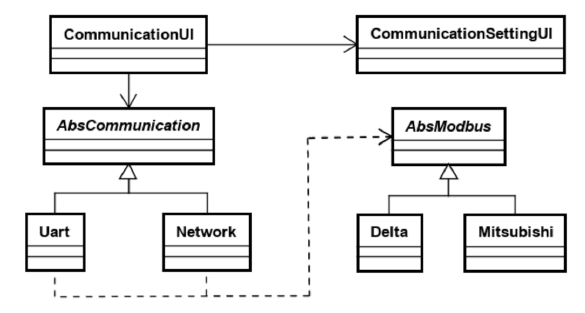
Figure 7. Improved communication-system architecture.